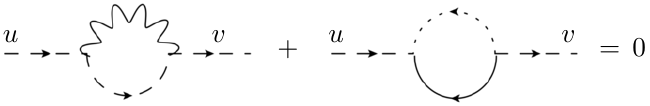
Figure 3 . The vanishing of the one-loop propagator of the Q super(cid:12)eld represented by a dashed line. In the second diagram, the continuous internal line represents the (cid:8) 1 = (cid:8) super(cid:12)eld of the = 2 theory, while the dotted line represents the Q super(cid:12)eld. The indices u and v belong to the N fundamental representation of SU( N ). The same happens if the role of Q and Q is exchanged. e